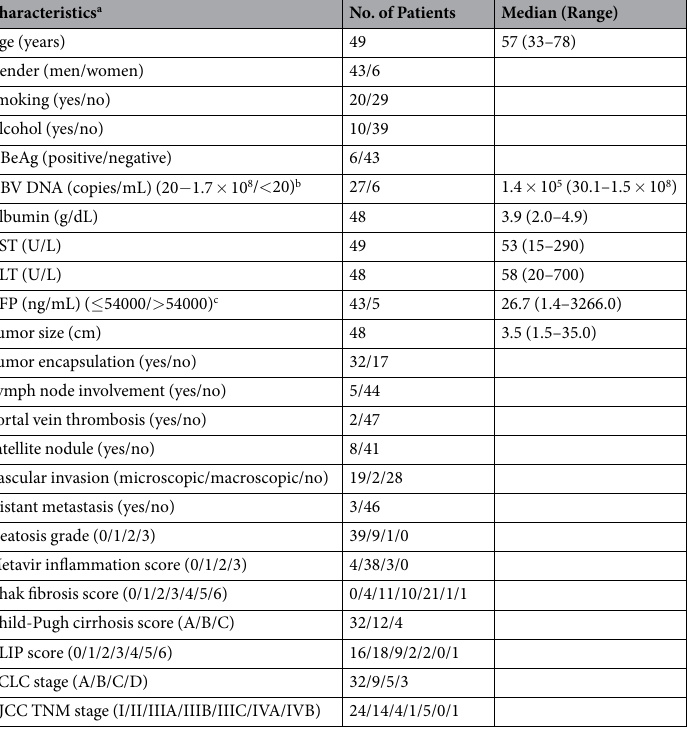
Table 1. Clinicopathological characteristics of the 49 HBV-related HCC patients enrolled in this study (continued). a Only patients with available data were analyzed. b HBV DNA was measured with a range of 20 to 1.7 × 10 8 copies/mL. c AFP was measured with the highest detection limit of 54000 ng/mL. Abbreviations: HBV, hepatitis B virus; HCC, hepatocellular carcinoma; HBeAg, hepatitis B e antigen; AST, aspartate aminotransferase; ALT, alanine aminotransferase; AFP, alpha-fetoprotein; CLIP, Cancer of the Liver Italian Program; BCLC, Barcelona Clinic Liver Cancer; AJCC, American Joint Committee on Cancer; TNM,